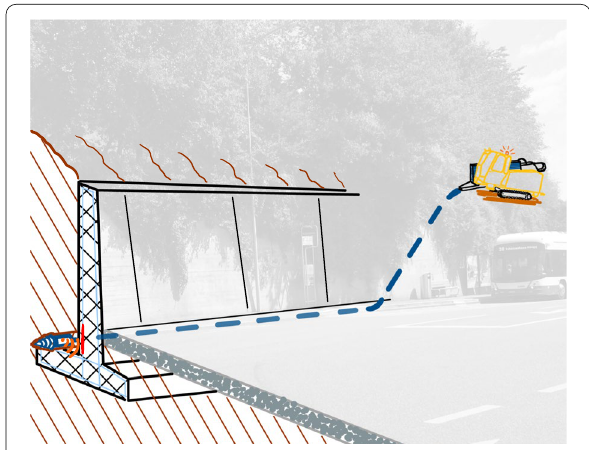
Fig. 2 Concept of the underground inspection method with directed horizontal drilling methods for retaining wall along the working joint where the suspected region for reinforcement corrosion is marked in red. Ideally, the inspection does not affect the traffic lanes